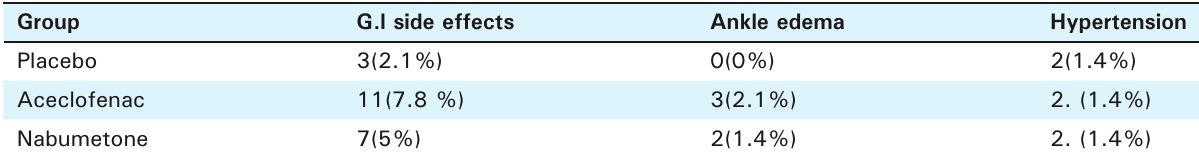
Table 2. Adverse events in placebo, aceclofenac (100 mg b.i.d.) and nabumetone (750 mg b.i.d) groups (Causes for discontinuation of therapy) Group